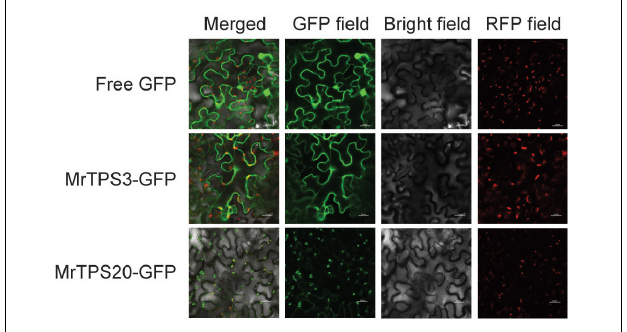
FIGURE 5 | Subcellular localization of MrTPS3 and MrTPS20. Free GFP served as a positive control and Arabidopsis RUBISCOA-RFP served as a marker located in chloroplast. Bars indicate 50 µ